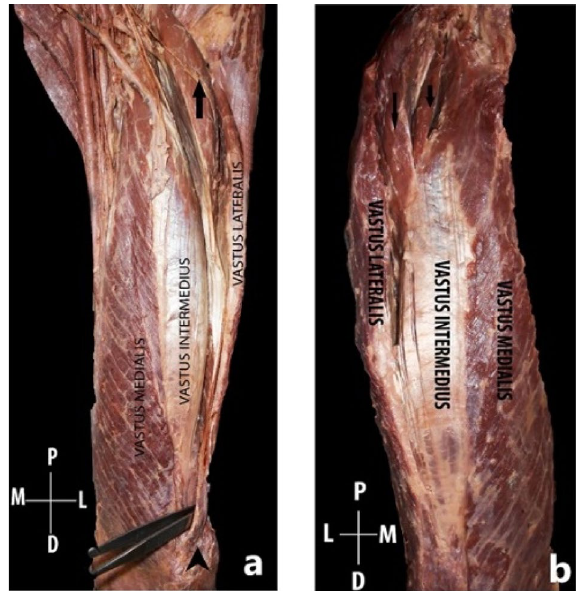
Figure 3. The insertion of the additional muscle head directly into the base of patella which is represented by a black arrowhead ( a ), the insertion of the additional muscle head into the aponeurosis of vastus intermedius ( b ). The black arrow shows the additional muscle head.